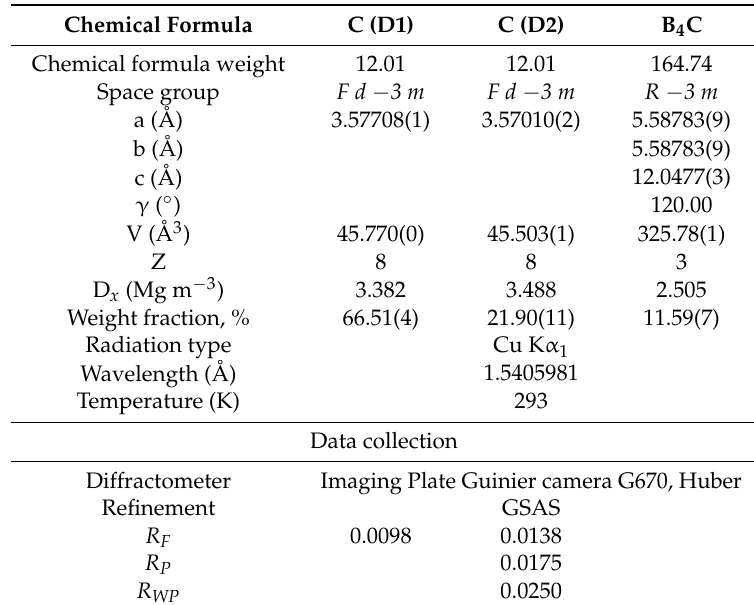
Table 2. Experimental details for D1, D2, and B 4 C (sample